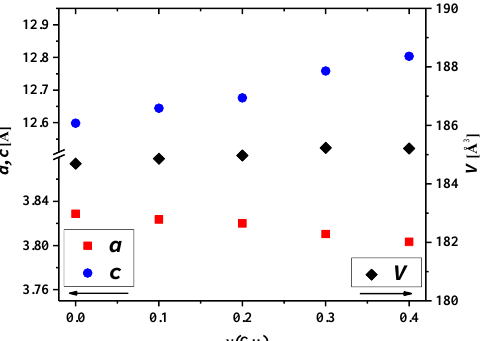
Figure 2. Dependencies of the unit cell parameters and volumes for the La 1.7 Ca 0.3 Ni 1−y Cu y O 4+ δ series on the Cu content.